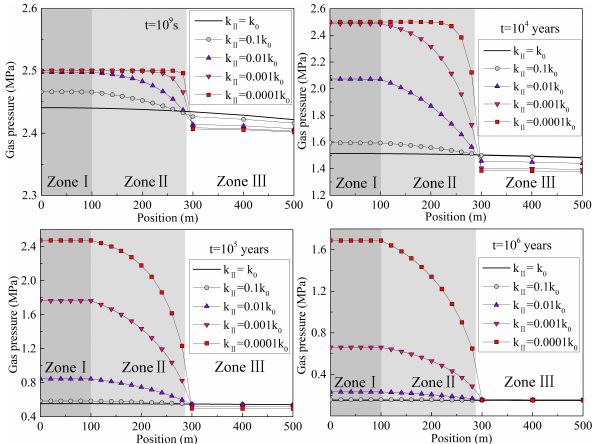
Figure 5. Gas distributions with various permeability properties of the low-permeability zone.